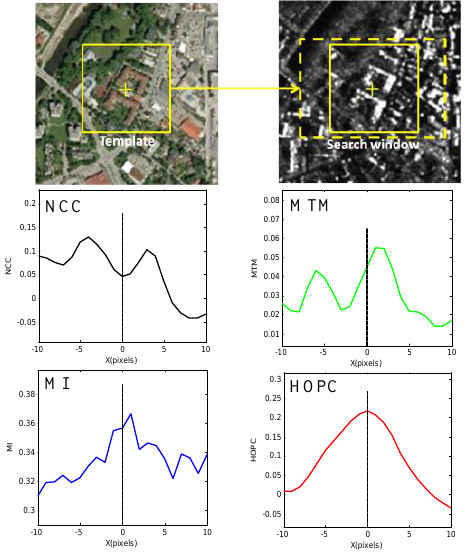
Figure 8 Similarity curves of NCC, MTM, MI and HOPC.